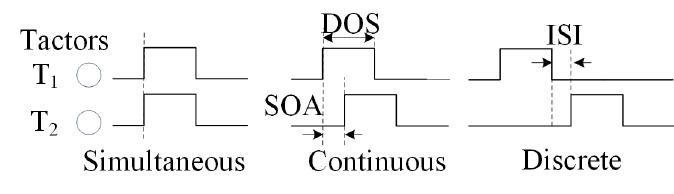
Figure 4. Schematic diagram of tactile apparent